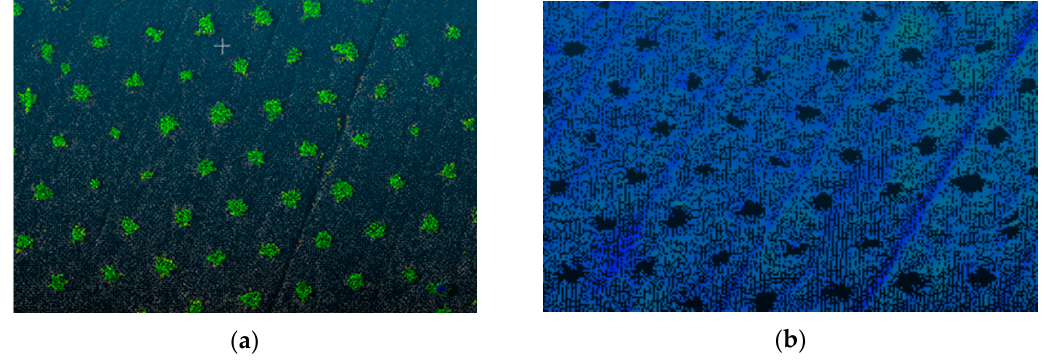
Figure 6. Point clouds: ( a ) original and ( b ) ground elevation after classification.